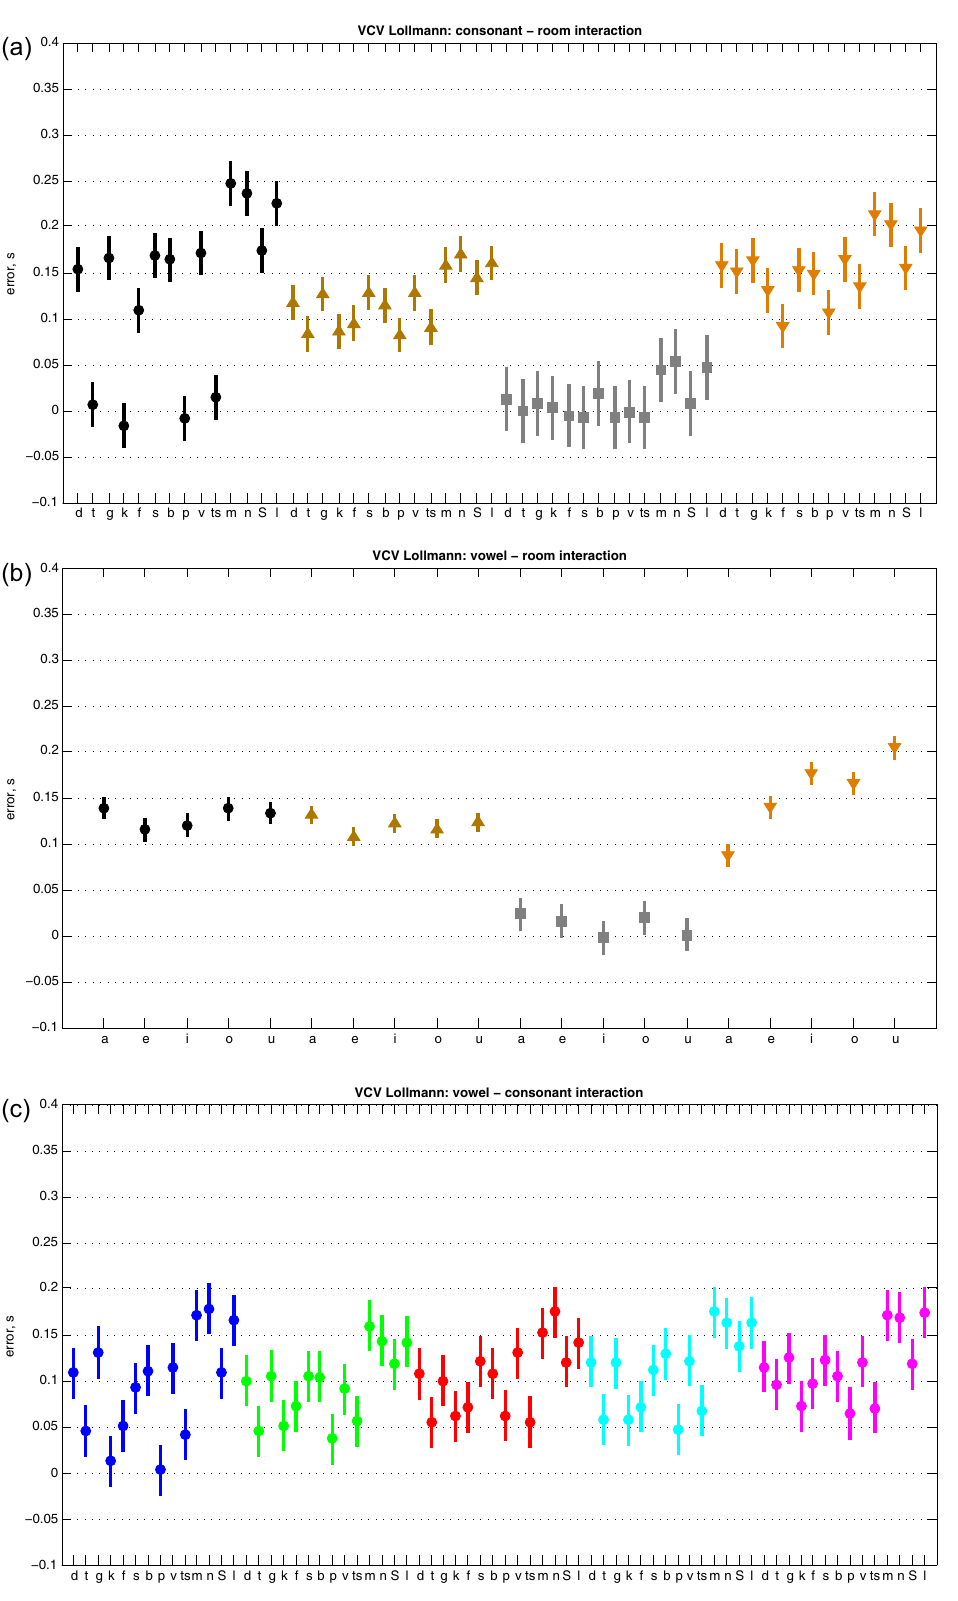
Figure 6. VCV logatomes: marginal means for Löllmann ’ s algorithm. (a) “ Consonant ” (cid:5) “ room ” interaction, (b) “ vowel ” (cid:5) “ room ” interaction, (c) “ vowel ” (cid:5) “ consonant ” interaction. For more details see Figure